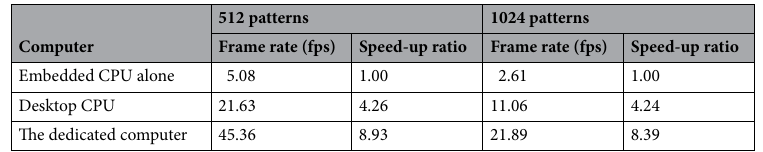
Table 2. Frame rate of each computer, and speed-up ratio relative to the embedded CPU alone. In the desktop PC, we used an analog-digital converter (ELMOS, FAD-16HS).